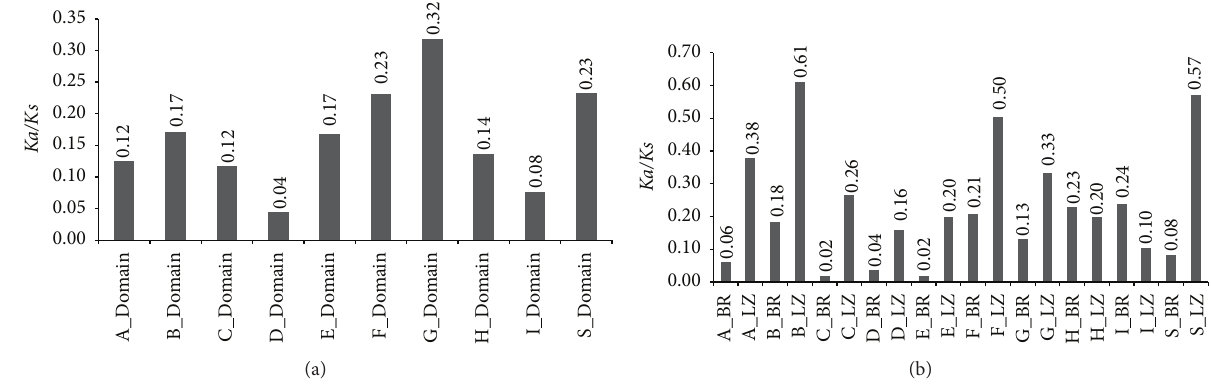
Figure 4: Ka/Ks ratios of bZIP domains. (a) Ka/Ks ratios of domains in clades A–S. (b) Ka/Ks ratios of BR and LZ domains in clades A–S. The Ka/Ks ratios are located in the top of the